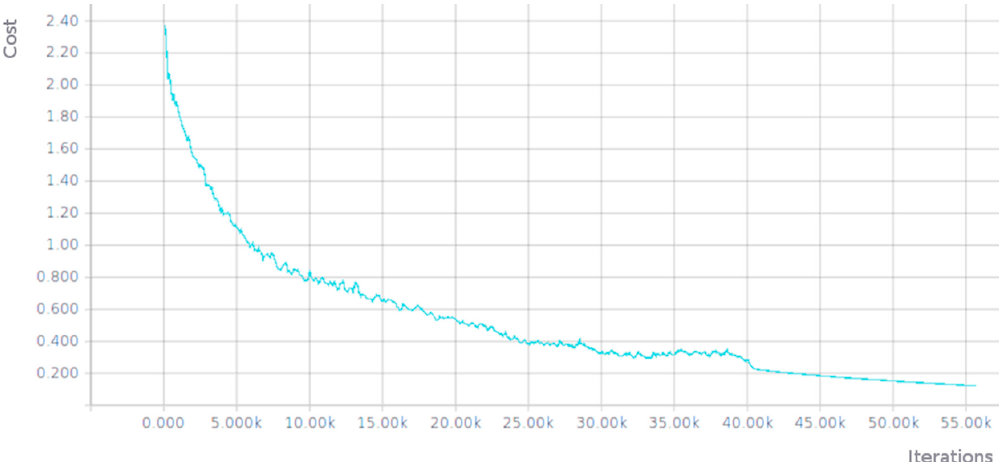
Figure 7 . Associated cost during training.